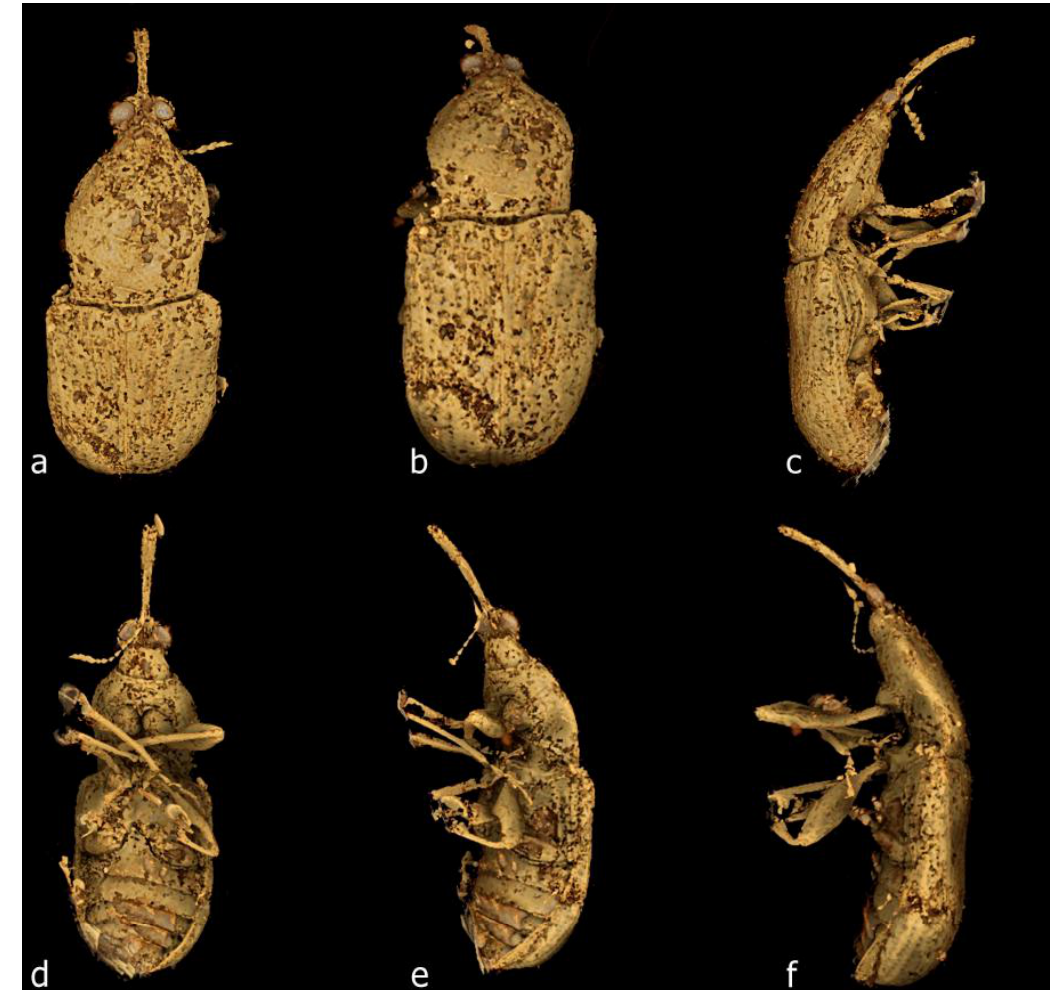
Figure 76. Periosocerus crenulatus sp. n., holotype. Habitus images extracted from a micro-CT scanning reconstruction (see also Video S7). Dorsal oblique ( a ); dorsal ( b ); right lateral ( c ); ventral ( d ); ventral oblique ( e ); left lateral ( f ).